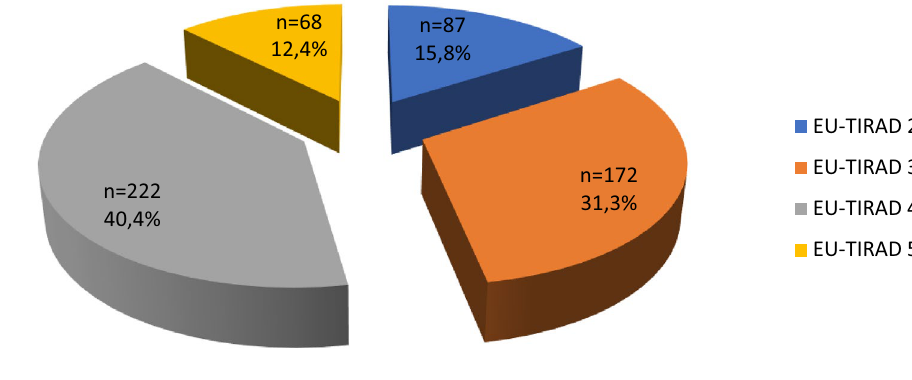
Figure 1. Classification of nodules according to the EU-TIRADS score.